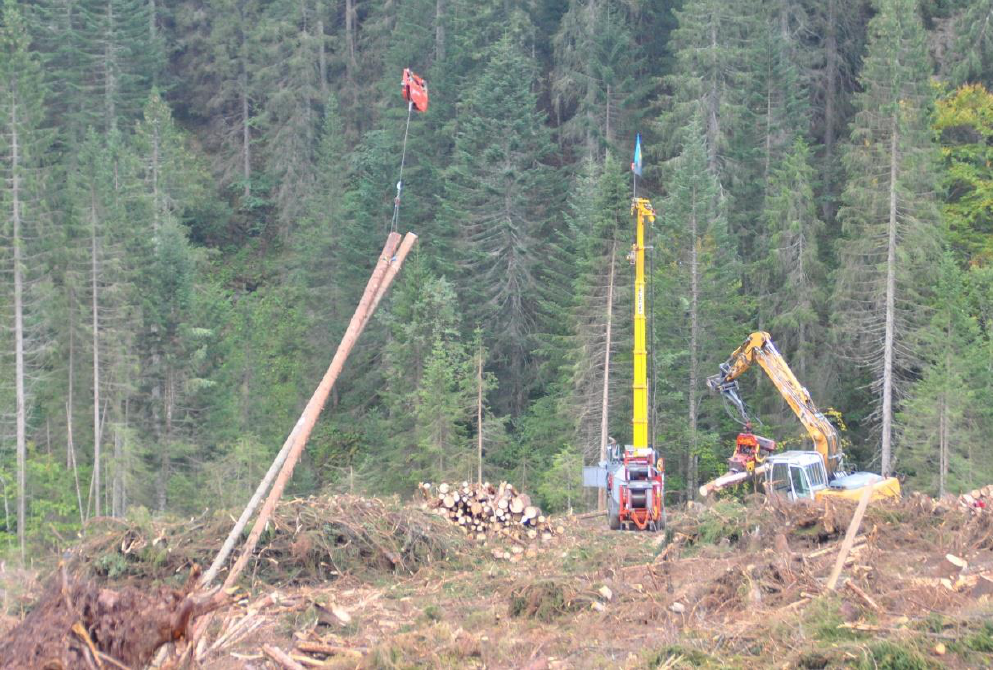
Figure 1. A typical cable yarding operation, included in this survey